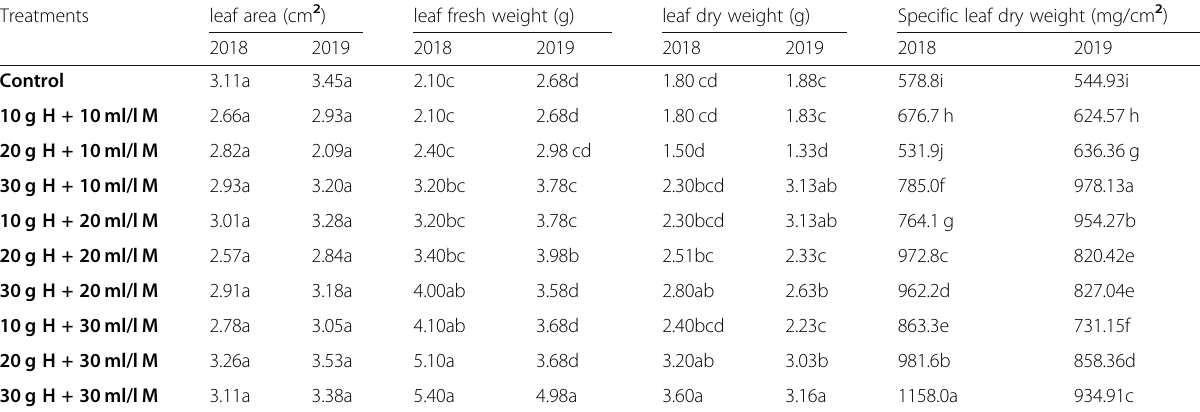
Table 3 Effect of soil application with humic acid and foliar spray of milagro on leaf area, leaf fresh weight, leaf dry weight, and specific leaf dry weight